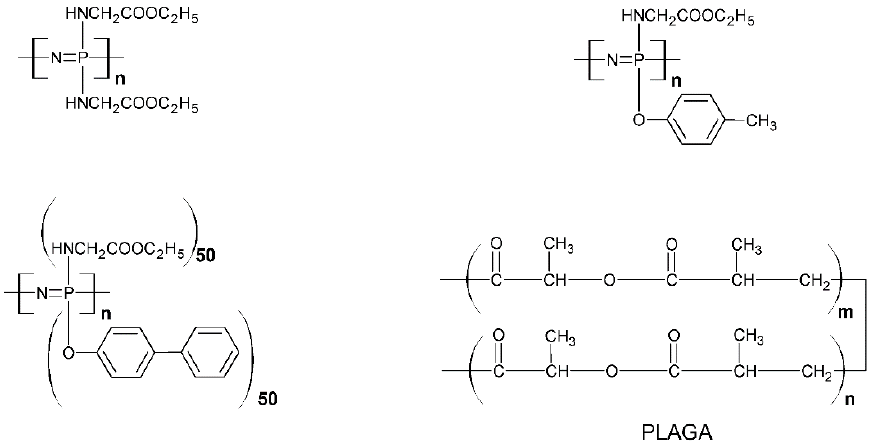
Figure 21. Biodegradable glycine containing polyphosphazenes for bone regeneration.